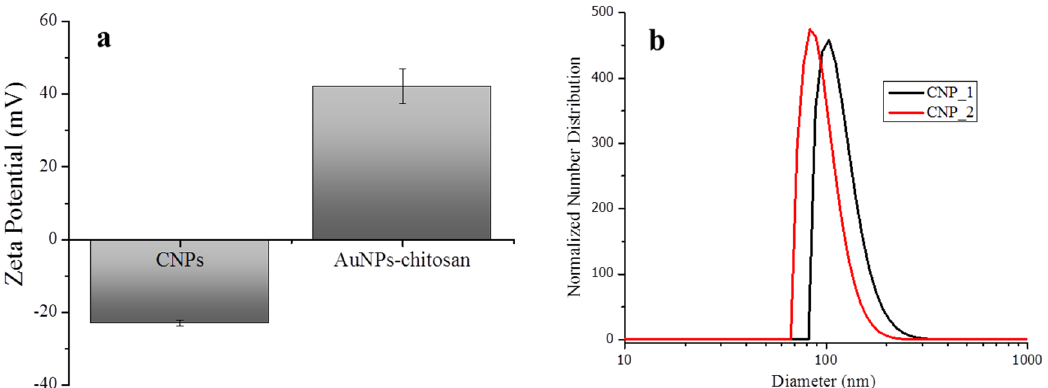
Figure 4. ( a ) Zeta potential for gold–chitosan (AuNPs–chitosan) and carbon nanoparticles (CNPs); ( b ) dynamic light scattering of the synthesized CNPs.